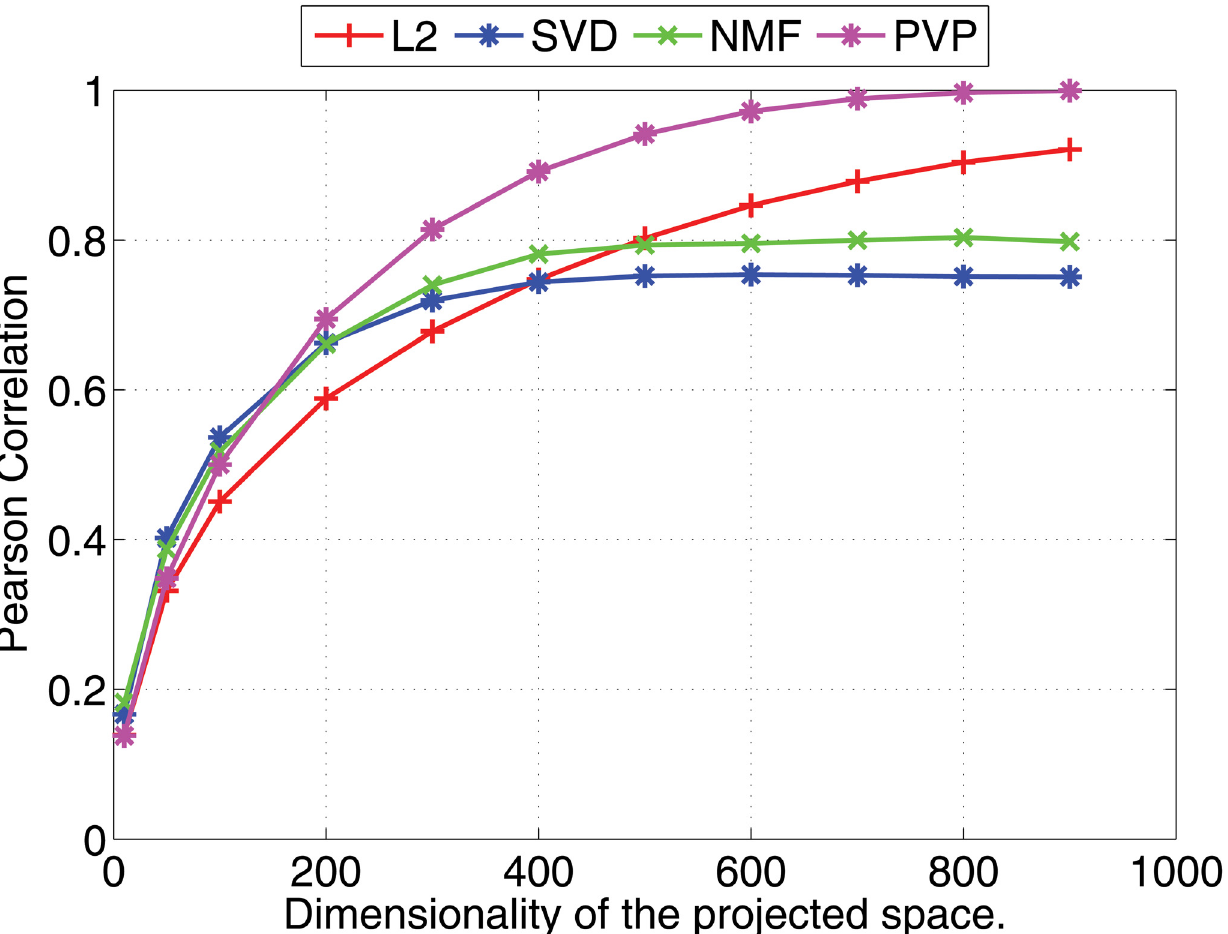
Fig 1. Nearest neighbor prediction with artificial data. Pearson ’ s r correlation coefficients for different dimensionality reduction methods are shown under varying dimensionalities (Feature vectors are 1000